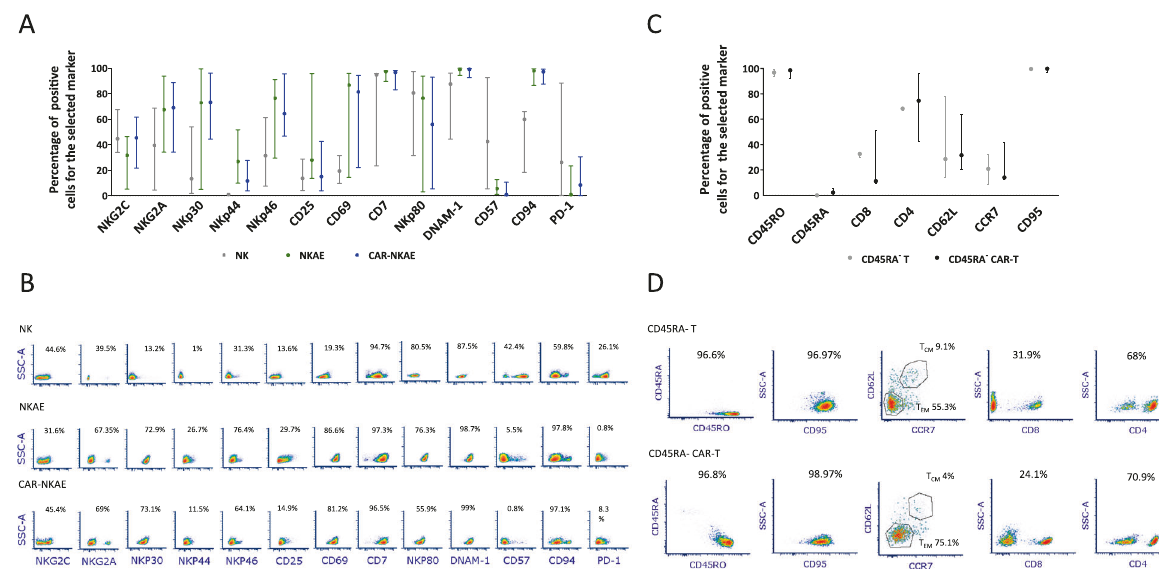
Fig. 3 Phenotype of NKAE cells and T cells. The expression pro fi le of different surface markers was analyzed by fl ow cytometry in untransduced and CAR-expressing ( A ) NKAE cells and ( C ) T cells. Data are represented as median and IQR of three different experiments. Statistical analysis was performed for each pair of untransduced and CAR-transduced cells. Representative density plots of ( B ) NK cells, NKAE cells, and CAR-NKAE cells and density plots of ( D ) CD45RA − T cells and CD45RA − CAR-T cells are